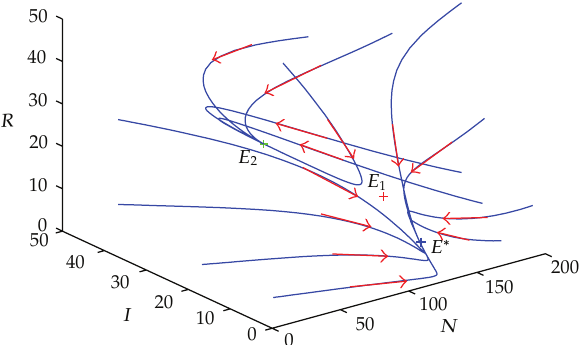
Figure 6: The phase diagram of system (cid:5) 1.4 (cid:6) when I 0 (cid:7) 10, A (cid:7) 100, β 1 (cid:7) 0 . 015, β 2 (cid:7) 0 . 001, γ (cid:7) 0 . 01, d (cid:7) 0 . 8, (cid:7) 1 . 0462, p (cid:7) 0 . 8156, p (cid:7) 1 . 2033, R (cid:7) 1 . (cid:4) (cid:7) 0 . 01, r (cid:7) 1, p 0 1 2 0